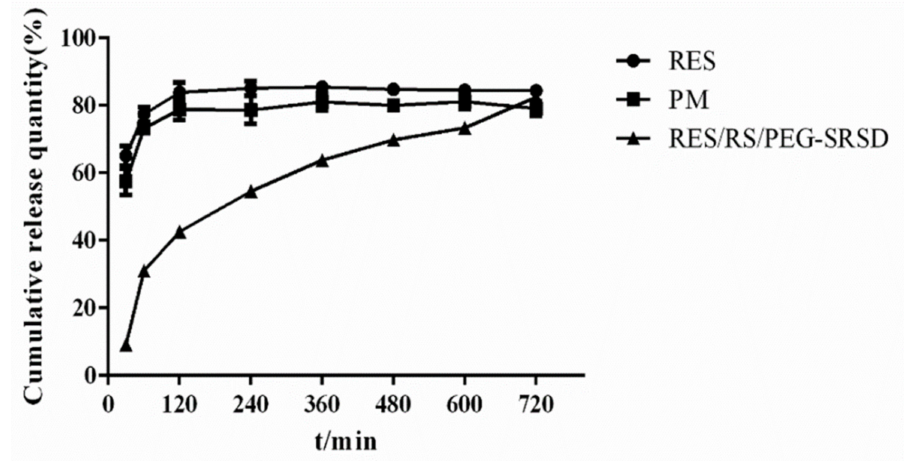
Figure 9. Dissolution curves of RES, physical mixture, and SRSD.